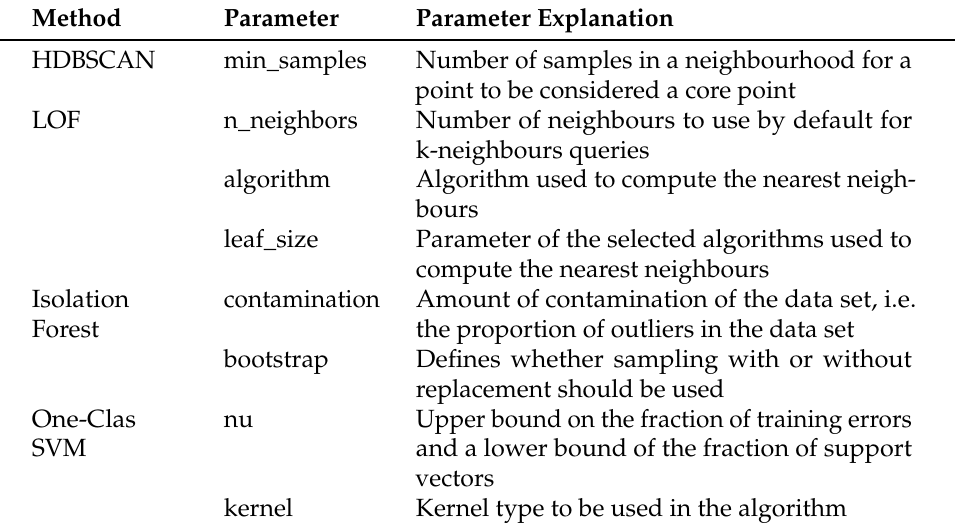
Table 1. Parameters tuned for each method evaluated as the base model in the proposed